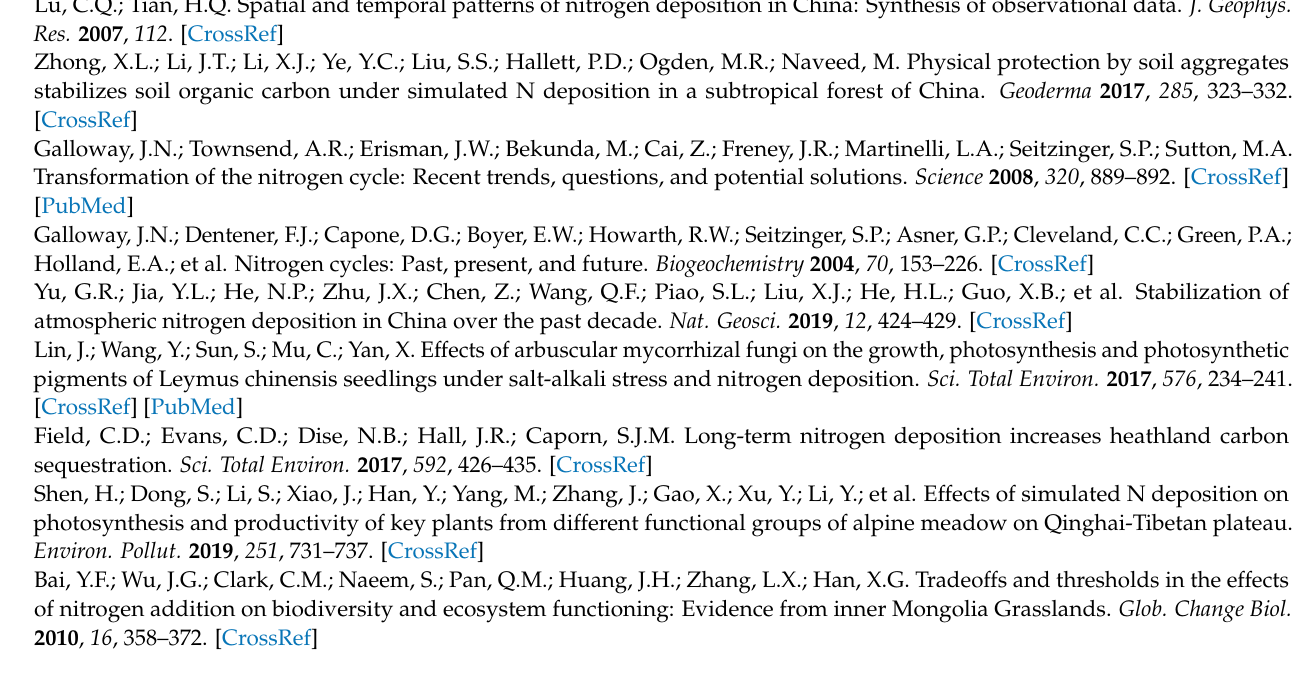
Table S3 The importance values of all species of alpine steppe under different N, Table S4 The changes of soil physicochemical under different N, Figure S1. Richness index (a), Shannon-Weiner diversity index (b), Simpson dominance index (c), Pielou Evenness index (d) of alpine steppe under different N addition levels. Different lowercase letters indicate significant differences among levels (P < 0.05). Error bars represent standard error (SE) (n = 3), Figure S2 The arrangement of experimental plots of different